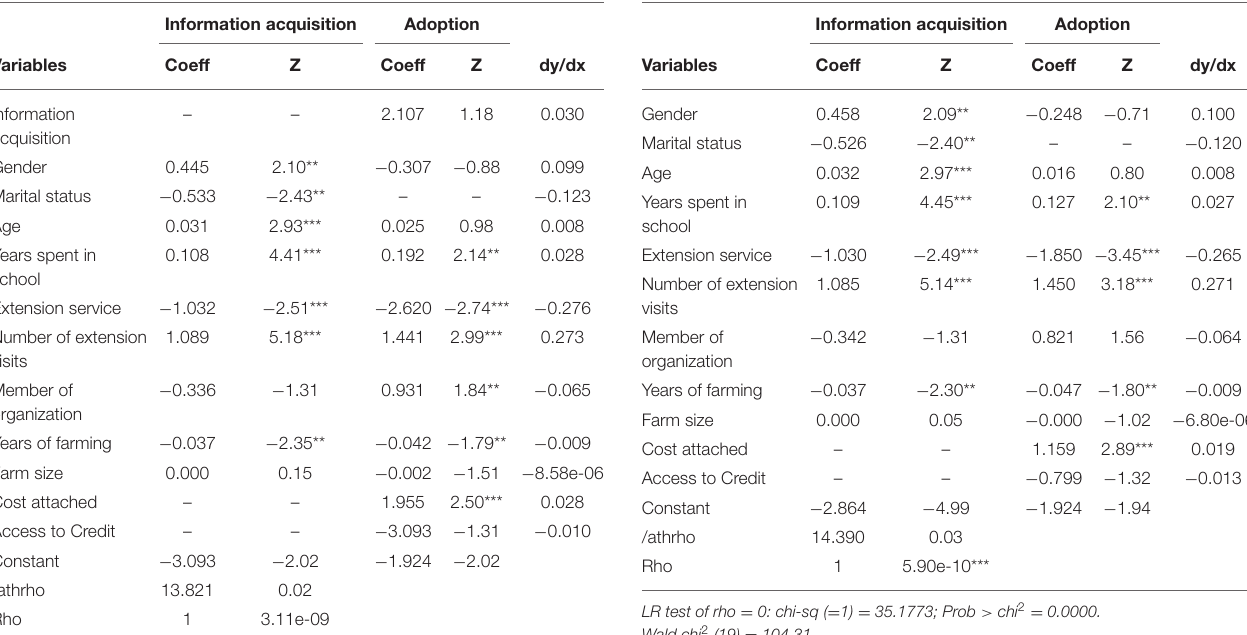
TABLE 4 | Recursive bivariate probit. TABLE 5 | Seemingly unrelated bivariate